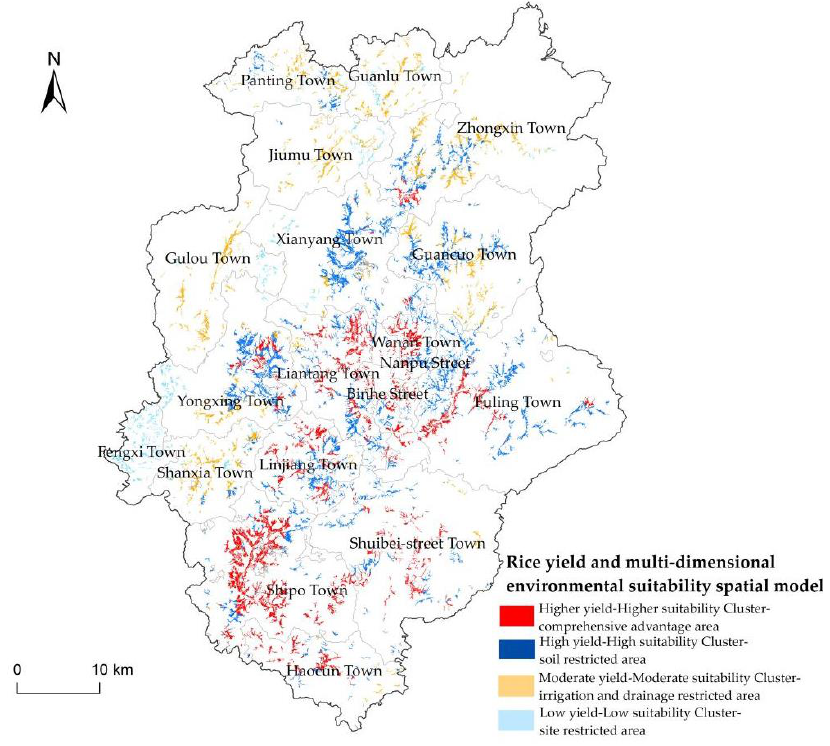
Figure 8. Rice yield and multidimensional environmental planting suitability spatial model.